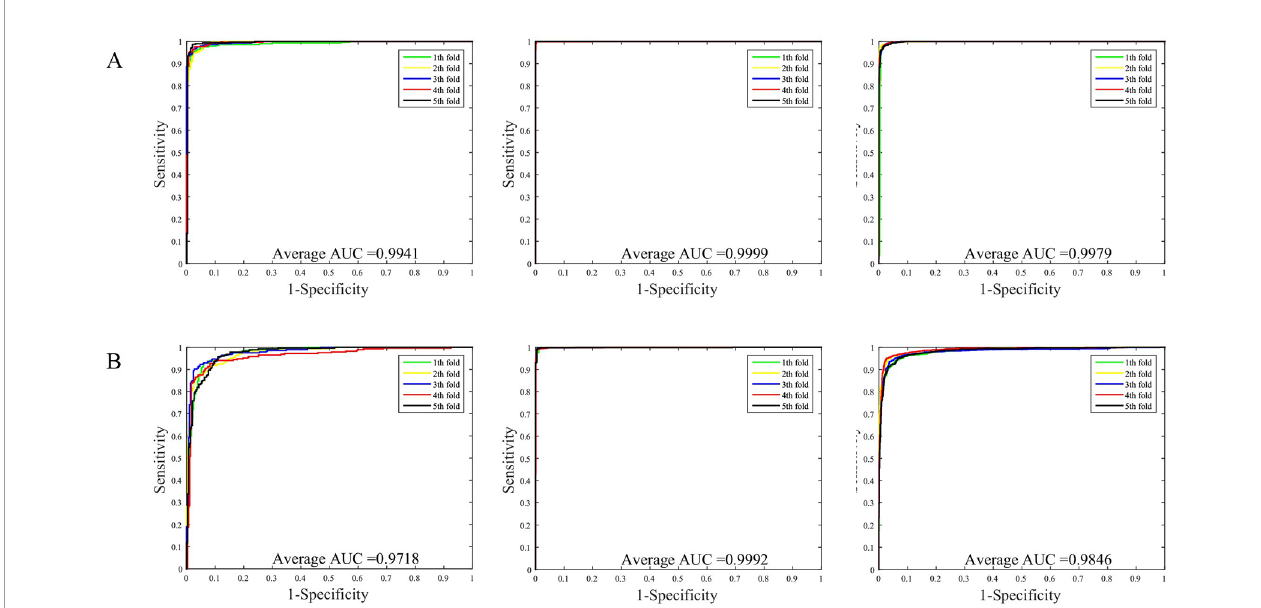
FIGURE 4 | (A) ROC curve of FCTP-WSRC on the H. pylori, Human and Yeast datasets. (B) ROC curve of FCTP-SVM on the H. pylori, Human and Yeast